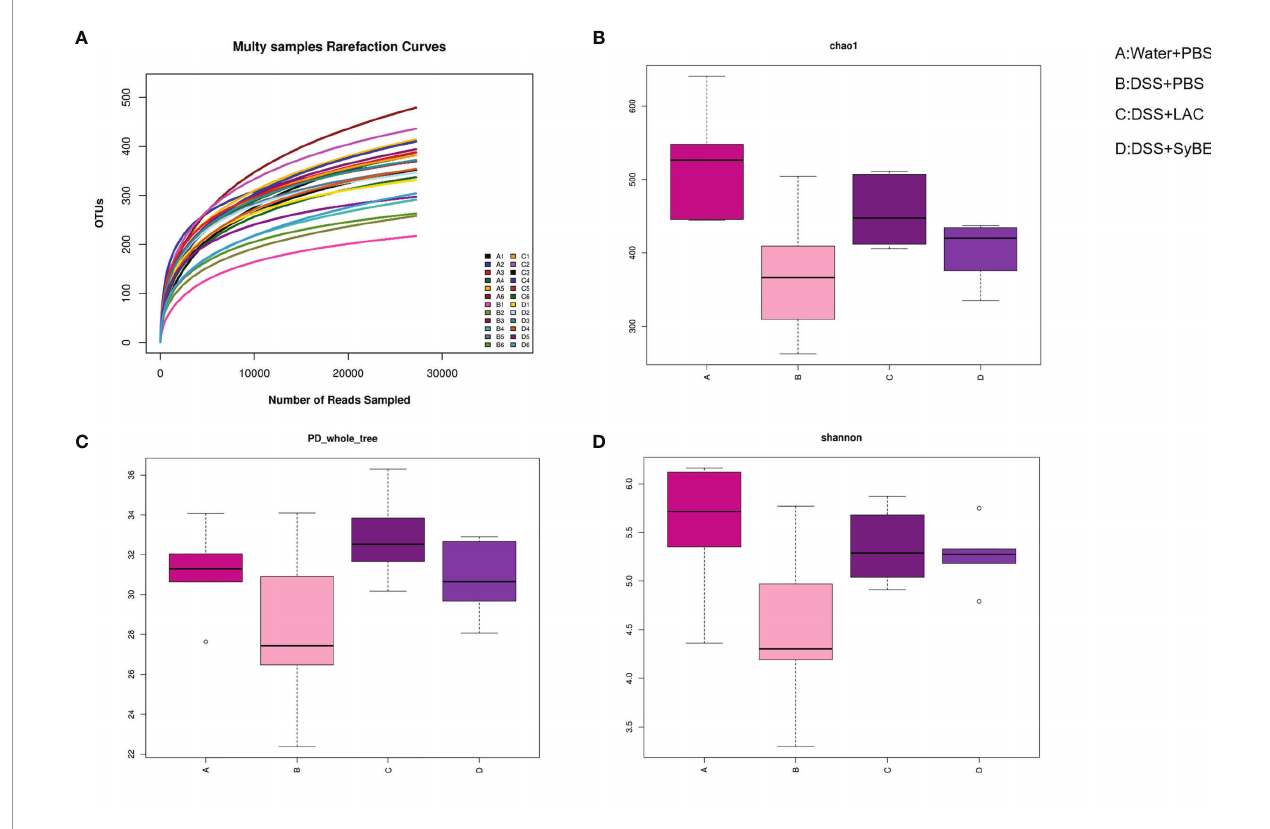
FIGURE 6 | Alpha diversity of the gut microbiota and rarefaction curves. (A) Rarefaction curves. (B) Chao1 index of all samples. (C) PD_whole_tree index of all samples. (D) Shannon index of all samples based on the operational taxonomic unit (OTU) level. (A) Water+PBS; (B) DSS+PBS; (C) DSS+LAC; (D) DSS+SyBE ( n =